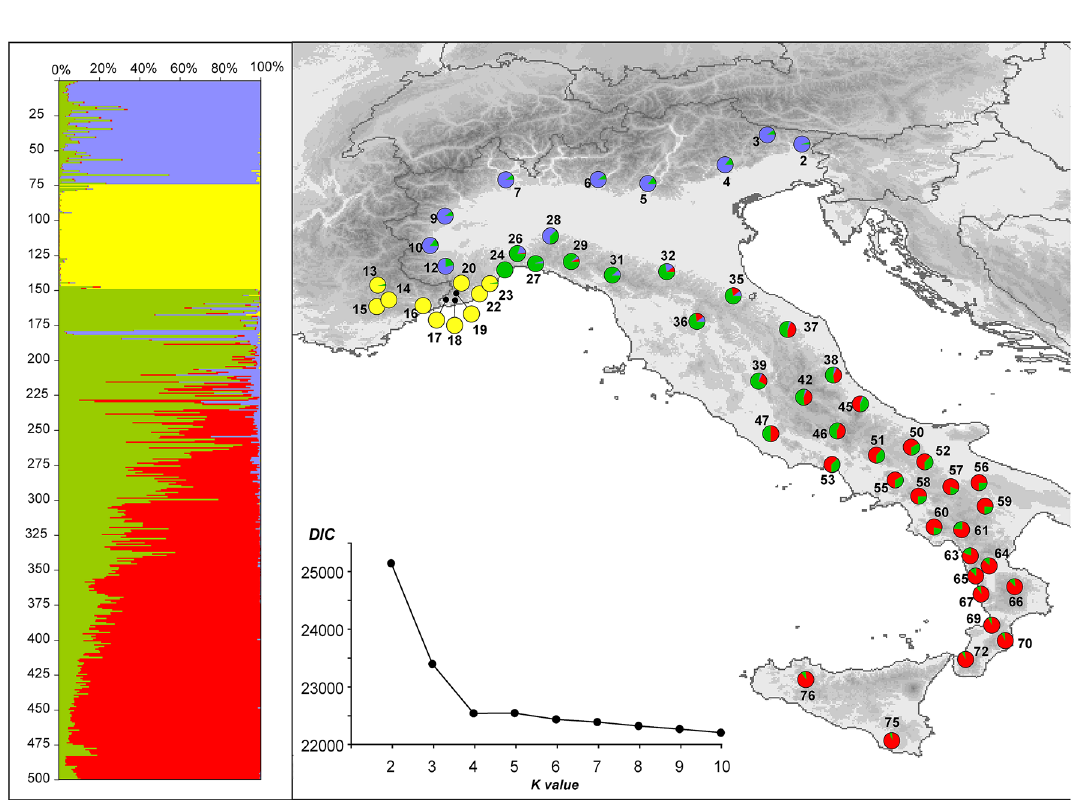
Figure 3. Genetic structure of the Italian Bufo bufo populations, as inferred by the Bayesian clustering analysis implemented in TESS based on eight microsatellite loci. The bar plot on the left shows the admixture proportions of each individual for the four genetic clusters identified; the pie diagrams on the maps show the frequency of each cluster within the studied populations. Populations are numbered as in Table 1. The line chart shows values of the deviance information criterion (DIC) statistics estimated for models with the number of genetic clusters (K) ranging from 2 to 10. The map was drawn using the software Canvas 11 (ACD Systems of America,